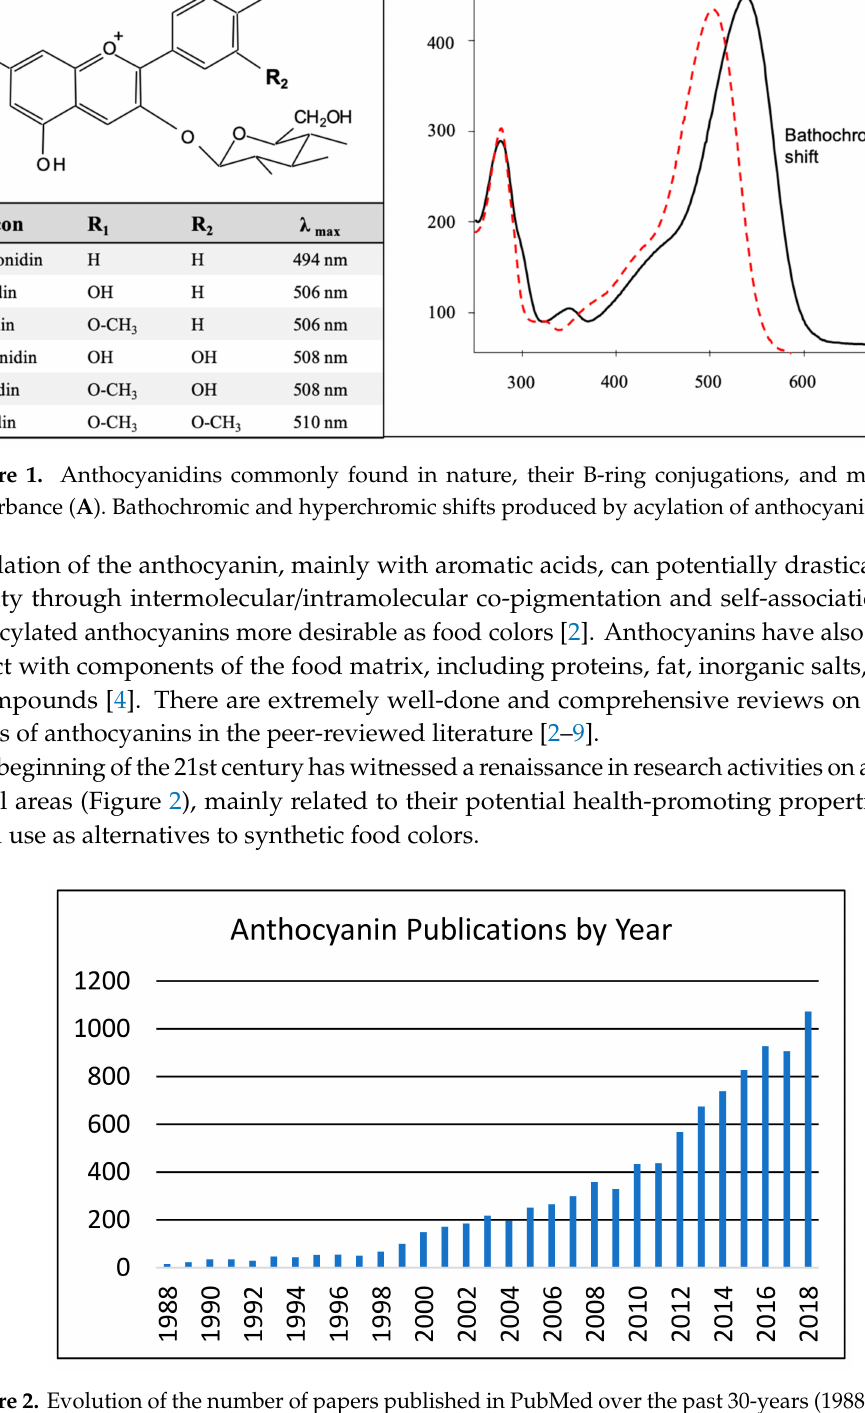
Figure 2. Evolution of the number of papers published in PubMed over the past 30-years (1988 to